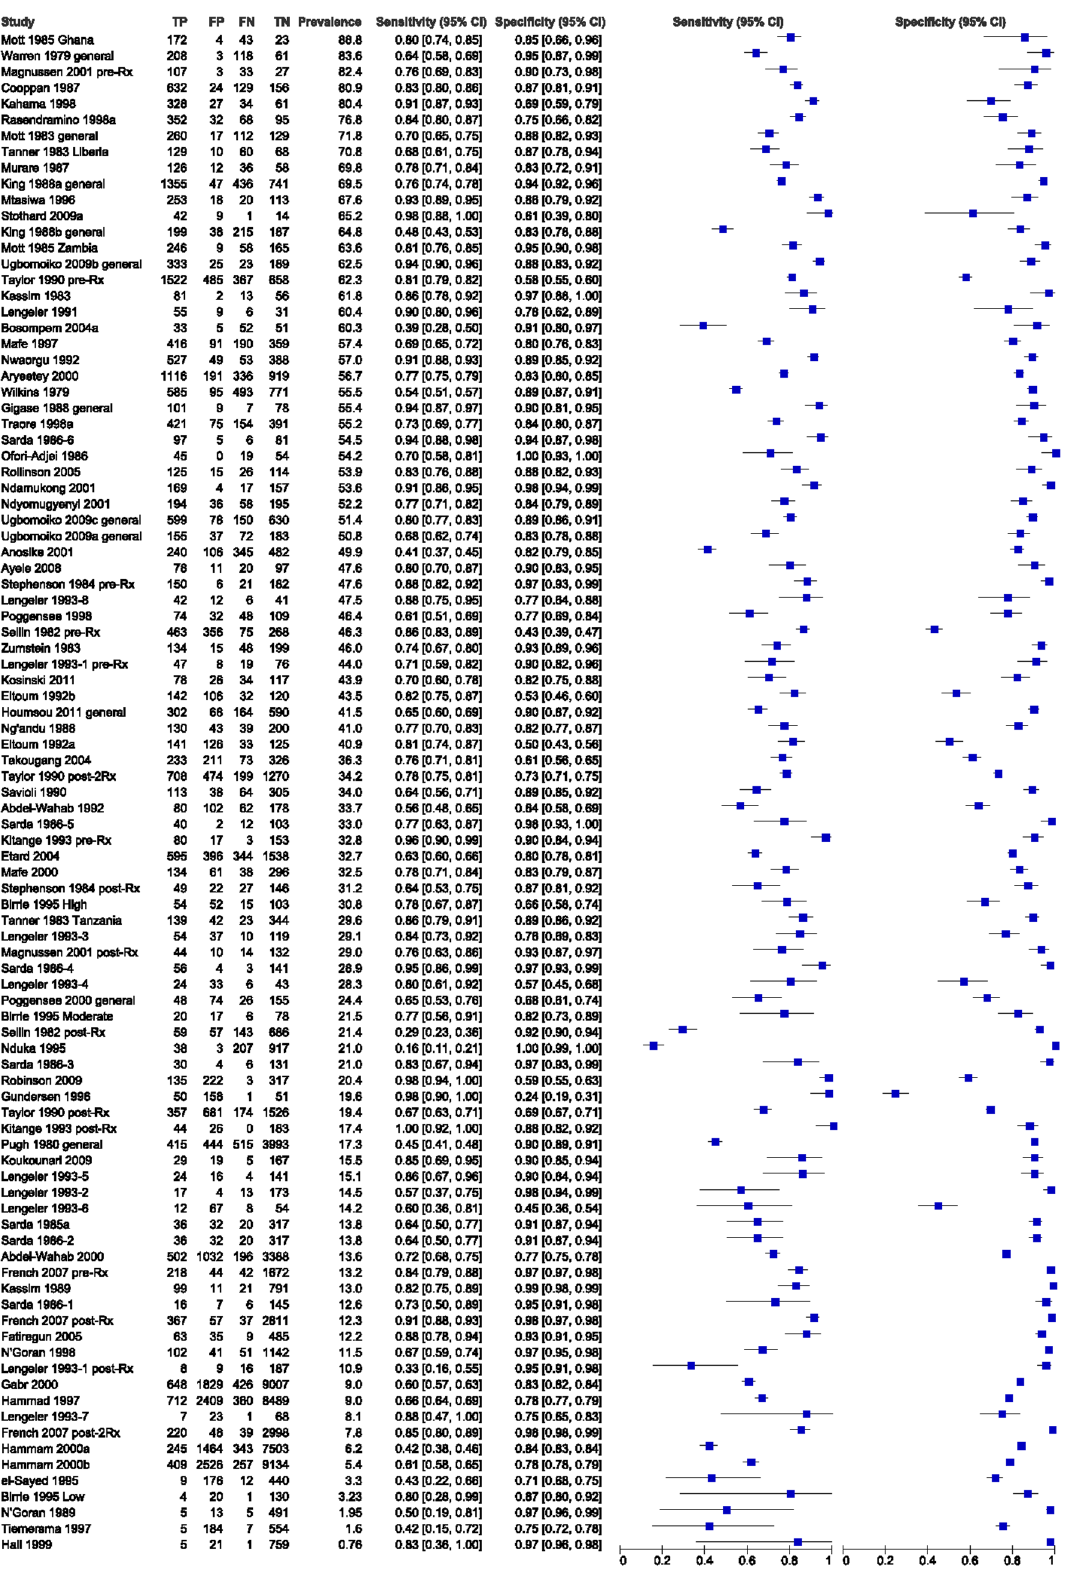
Figure 2. Forest plot of dipstick sensitivity and specificity according to prevalence of egg-positive urines in study. All included studies are listed in descending order of study prevalence of egg-positive urines, starting with their brief citation, then individual data on observed true- positives, false-positives, false-negatives, true-negatives, then study population prevalence. Center columns indicate calculated sensitivity and specificity for each study, with their respective 95% confidence intervals. The forest plots along the right-hand side graphically indicate observed dipstick sensitivity and specificity for each study (blue squares), while the horizontal black lines indicate the 95% confidence interval for each value. doi:10.1371/journal.pntd.0002431.g002 PLOS Neglected Tropical Diseases |